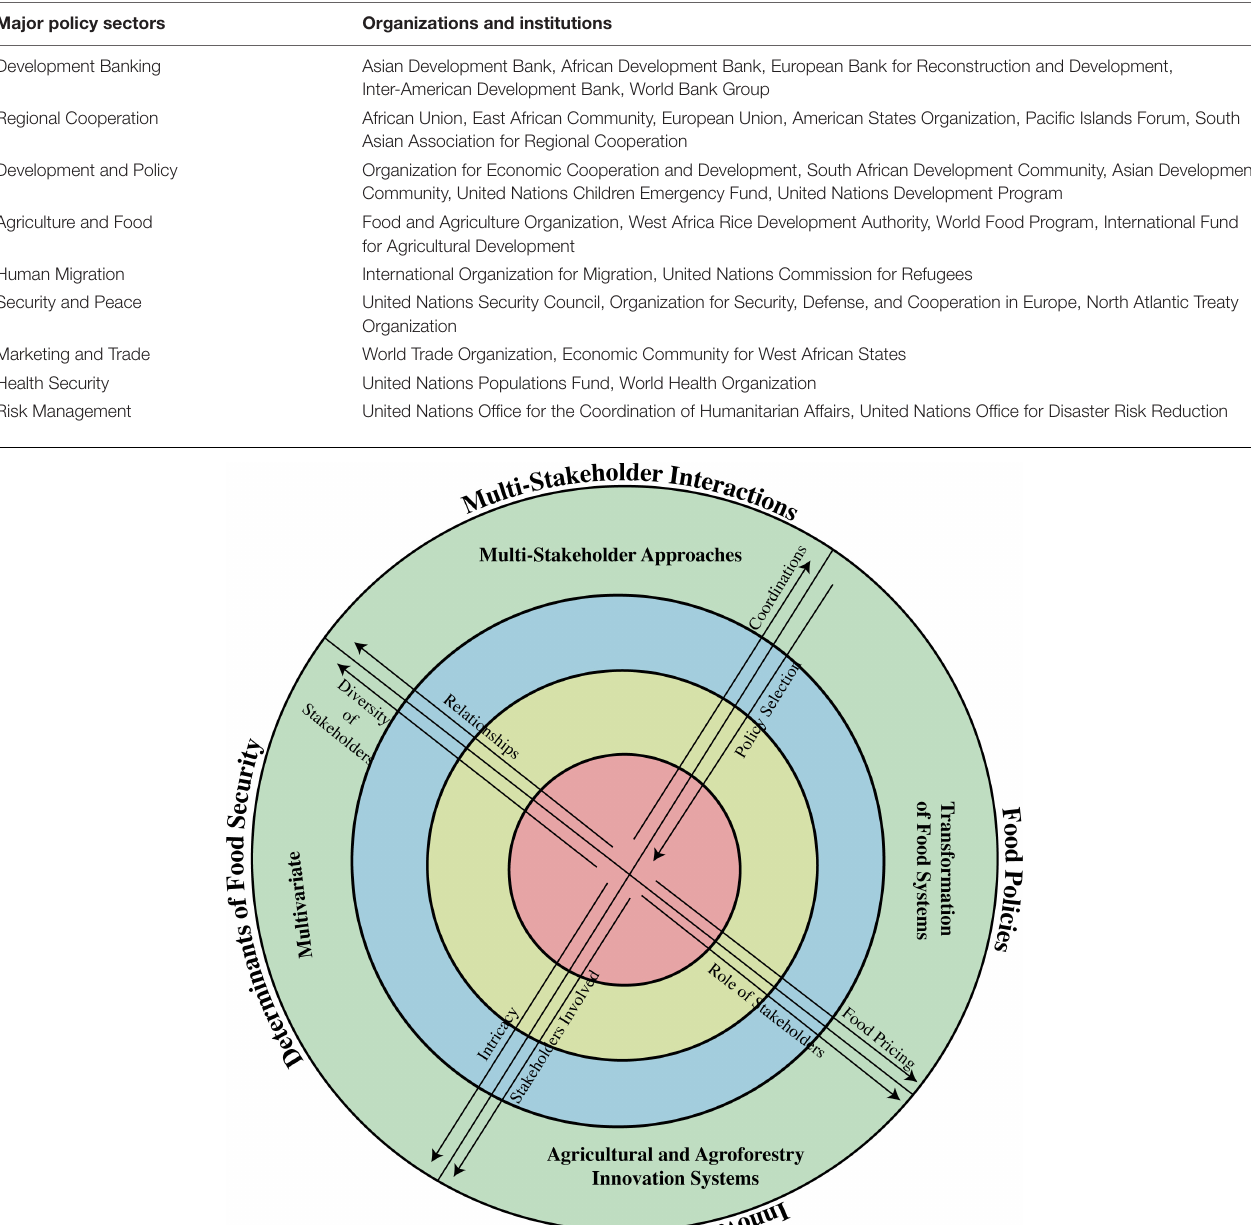
TABLE 3 | Different international and national funding agencies in different continents currently working to address the issues of climate change and risk management.